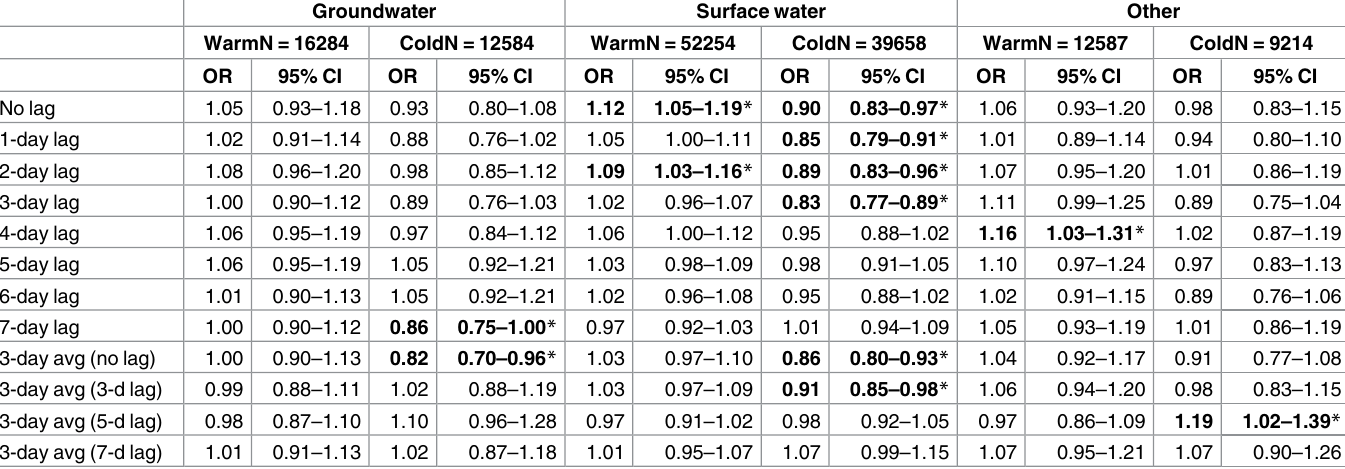
Table 3. Adjusted odds ratios (OR) and 95% confidence intervals (CI) of association with 90 th percentile precipitation and hospitalizations for gas- trointestinal illness by season and water